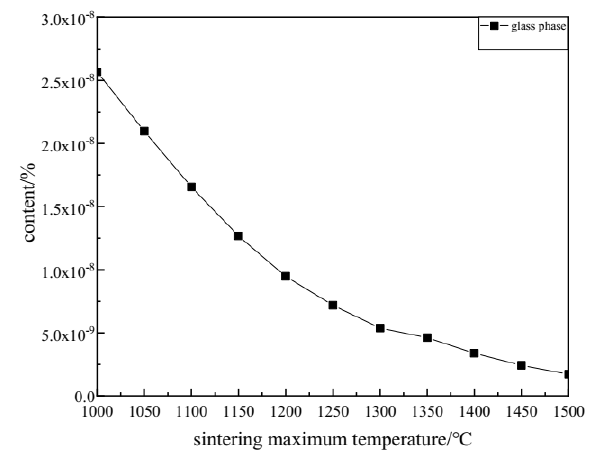
Figure 7. Change of glass phase content in sinter ore in case of straw charcoal substitution.